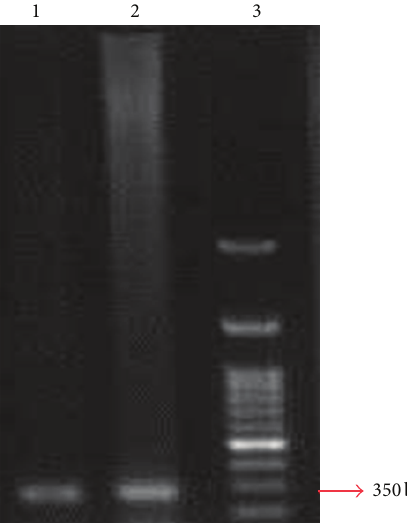
Figure 1: PCR product of Toxoplasma gondii amplified by UPRT primer.Lane1:positivecontrol(strainRhof Toxoplasmagondii (type I)), lane 2: patient’s amniotic sample, and lane 3: molecular